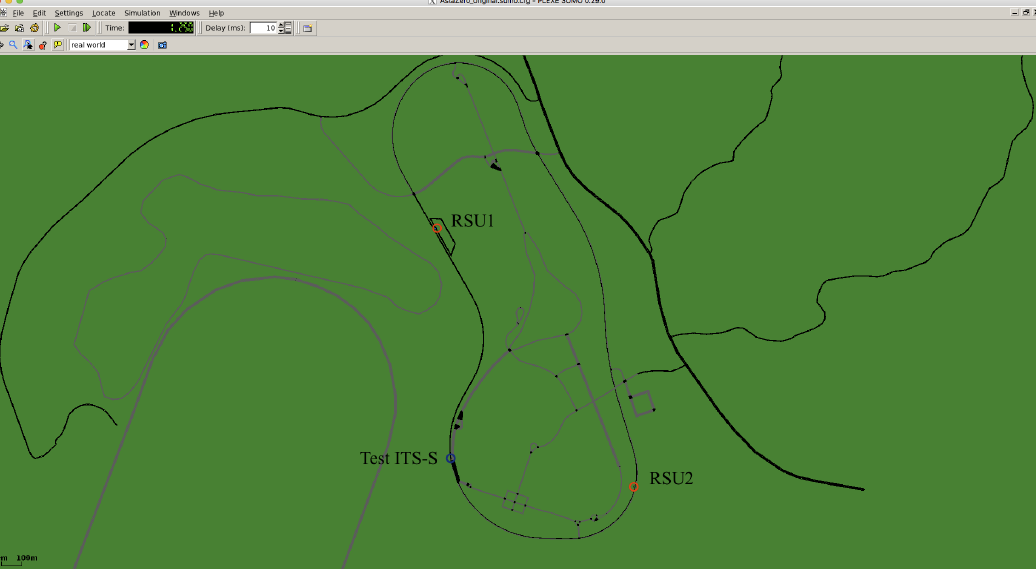
Figure 9. AstaZero test area in simulation